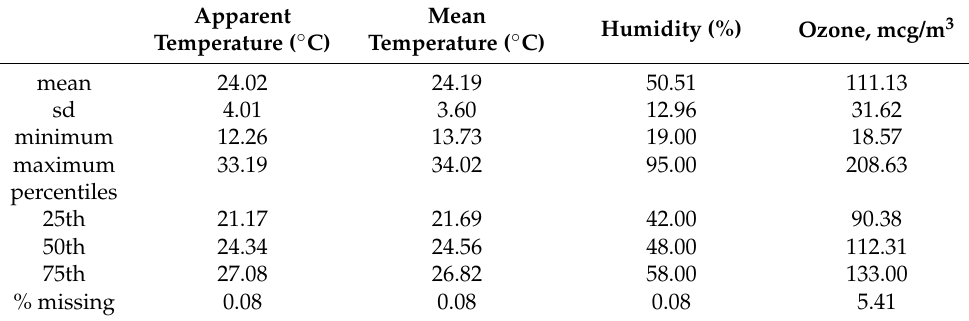
Table 1. Environmental variable statistics, Bologna 2010–2019.